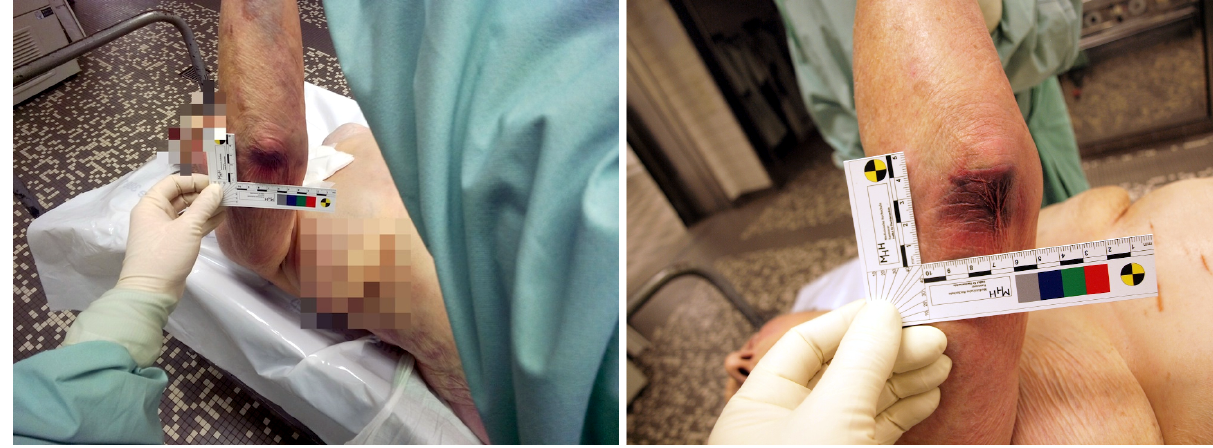
Figure 3. Similar phases of a postmortem on the same body with photo documentation (image anonymized for patient confidentiality). The image on the left was taken with Google Glass and the image on the right with the DSLR